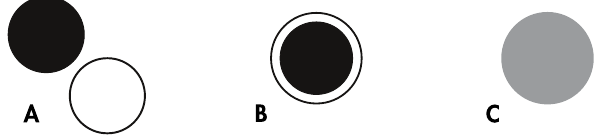
Figure 1. Schematic illustration of three mixing states. In externally mixed aerosols different types of particles coexist, each consisting of a single component (a) , whereas in internally mixed aerosols the particles consist of a combination of components (b, c) . An inter- nal mixture can be either inhomogeneous, e.g. having a core-shell structure (b) , or homogeneous (c) . External mixtures (a) are least absorbing, as the increased cross section affected by absorbing com- ponents in an internal mixture (b, c) outweighs the decreased ab- sorption